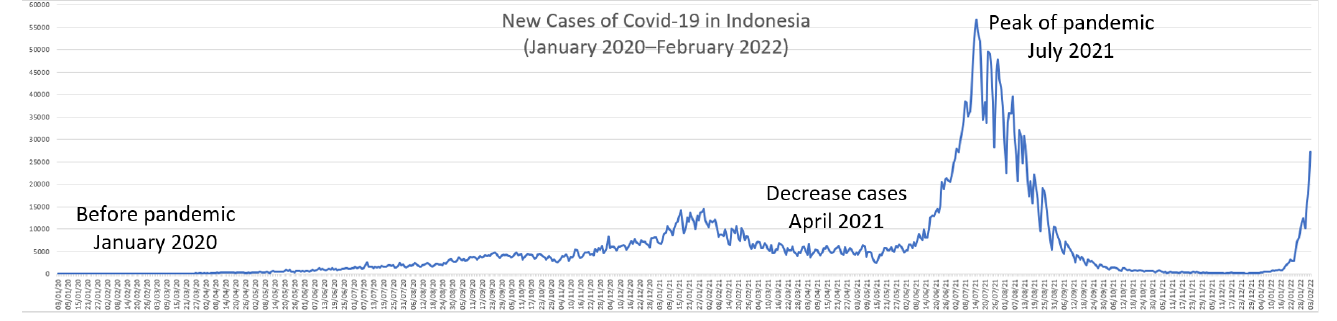
Figure 1. New cases of COVID-19 in Indonesia [3].